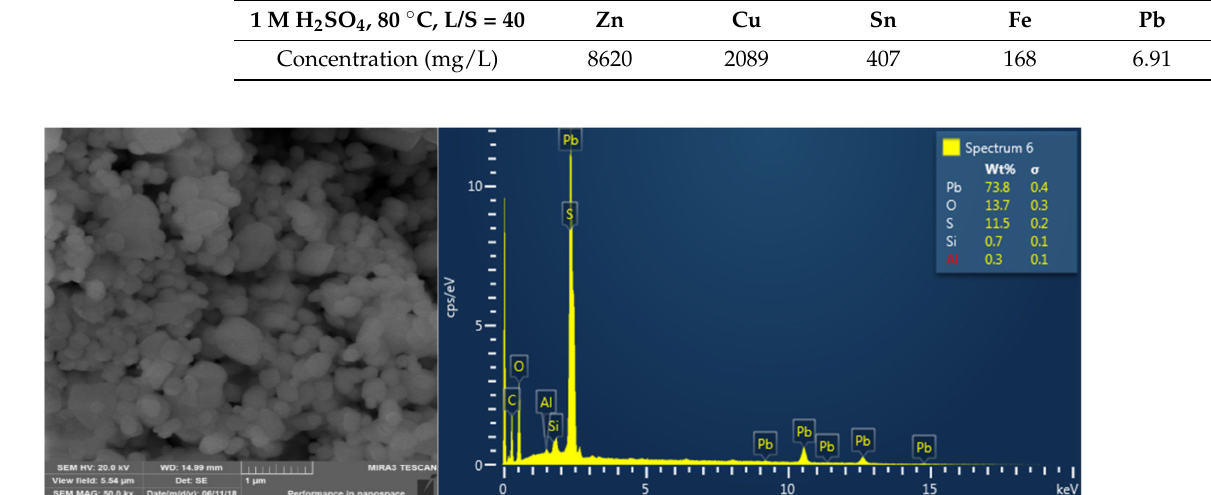
Table 3. Concentration of elements in solution after leaching in 1 M H 2 SO 4 at 80 ◦ C.